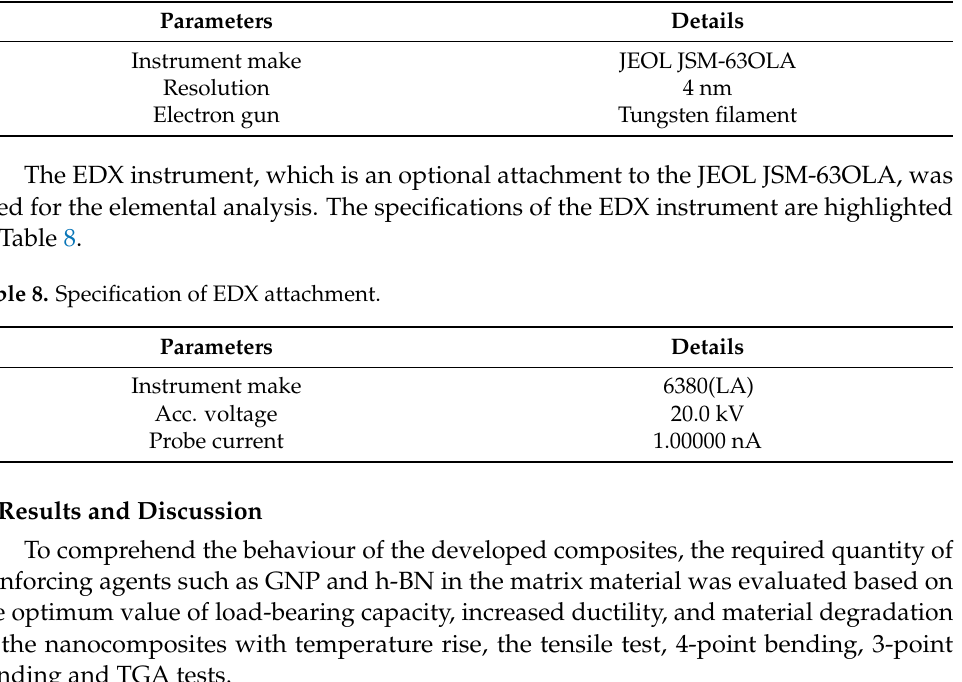
Table 7. Specification of SEM.